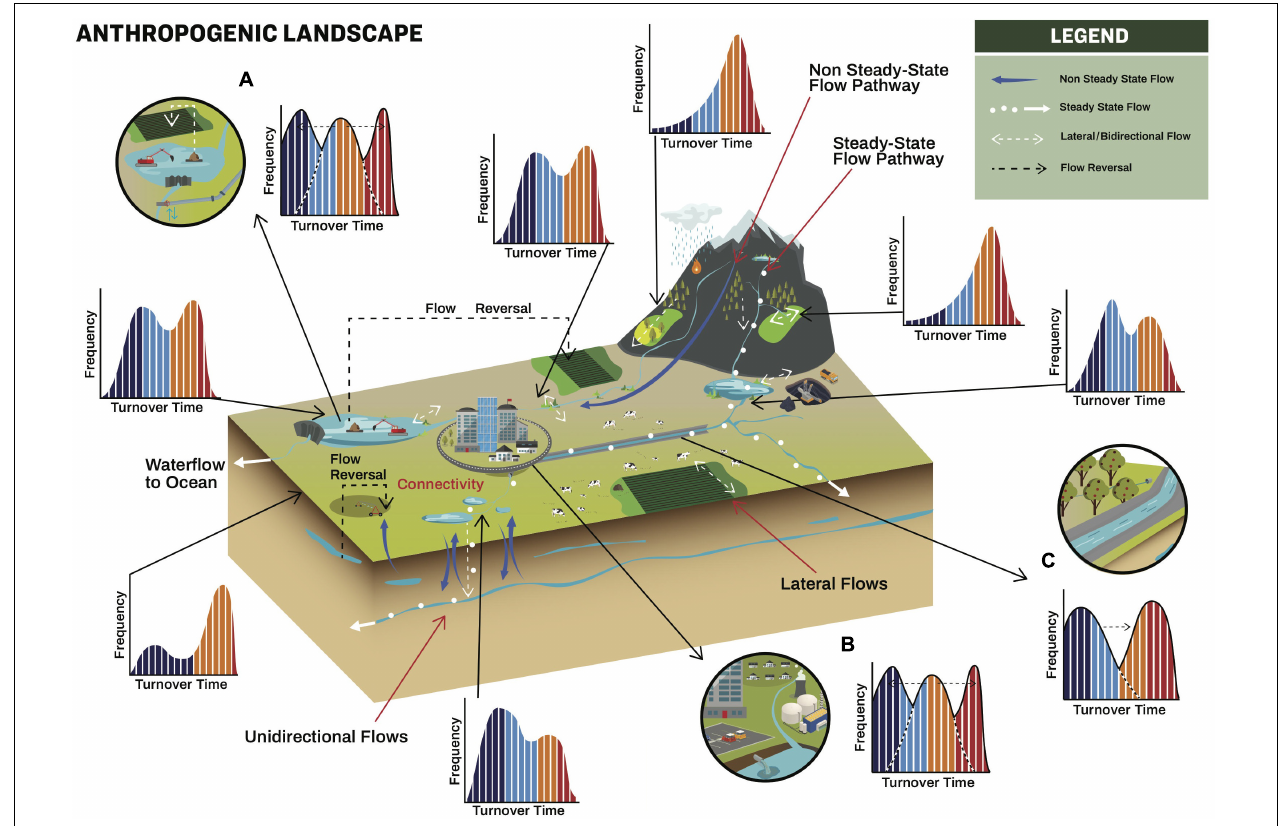
FIGURE 2 | Organic matter pathways across a landscape with anthropogenic structures. Different flows across the landscape are depicted along with frequency histograms of OM turnover. The colors within the histograms refer to the different spatio-temporal impact on turnover (see Table 1 and Figure 4 ). Insets (A–C) highlight the impact of flow reversals and structural changes on OM